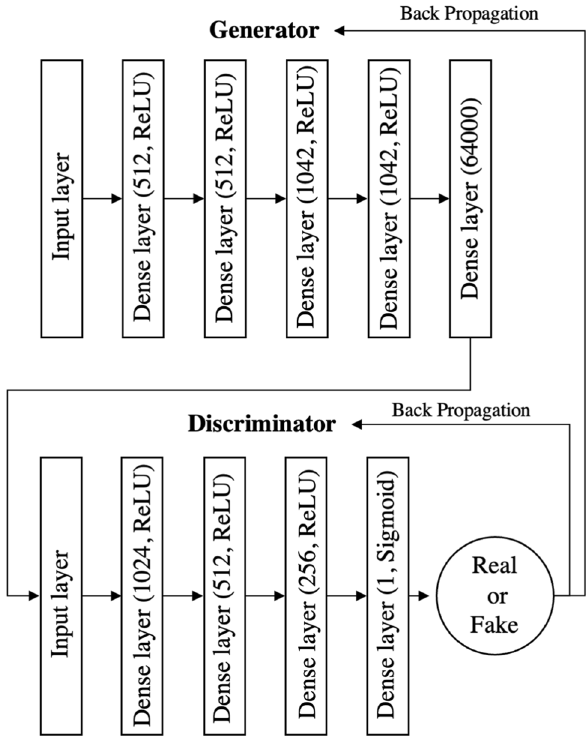
Fig. 6 Generic architecture of the Generative